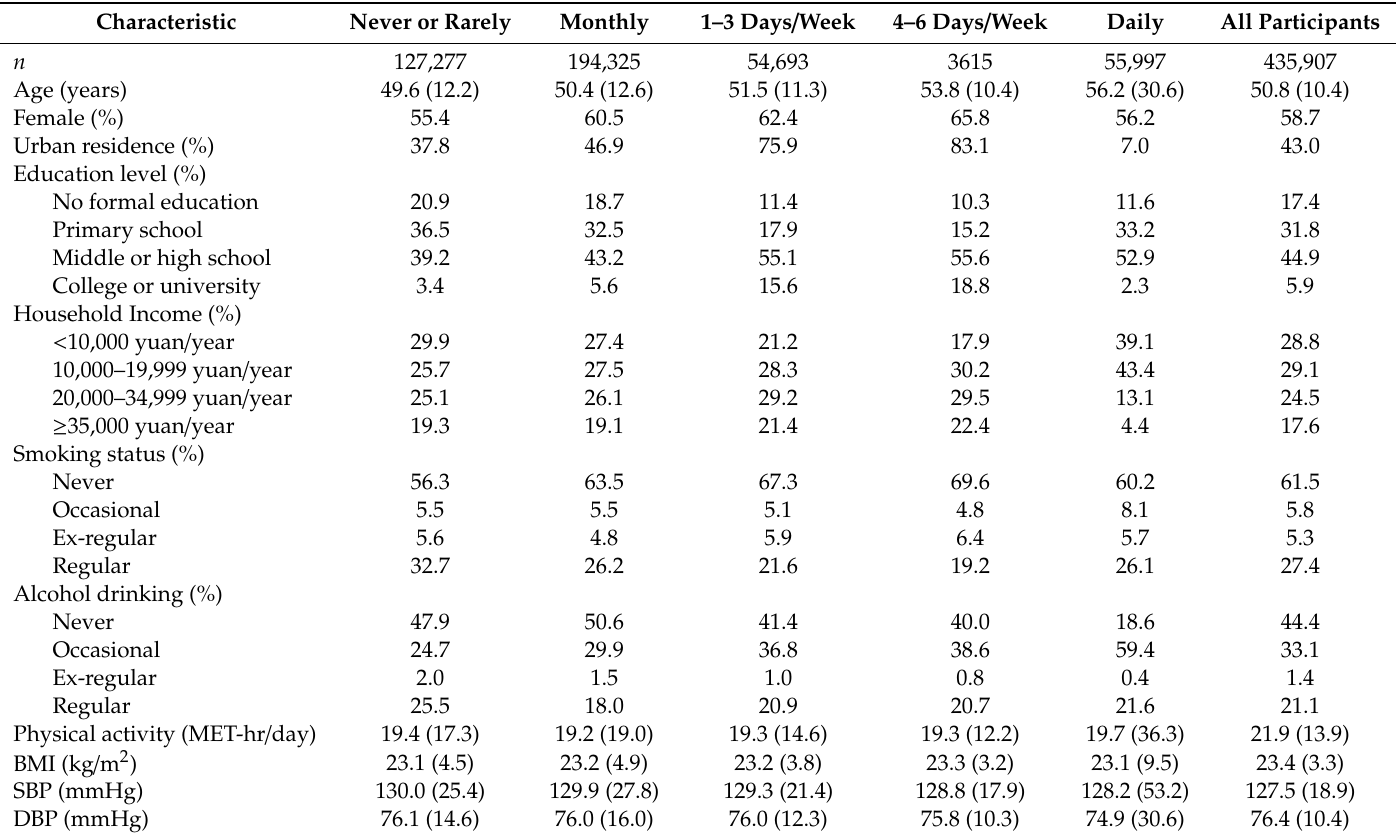
Table 1. Characteristics of the participants